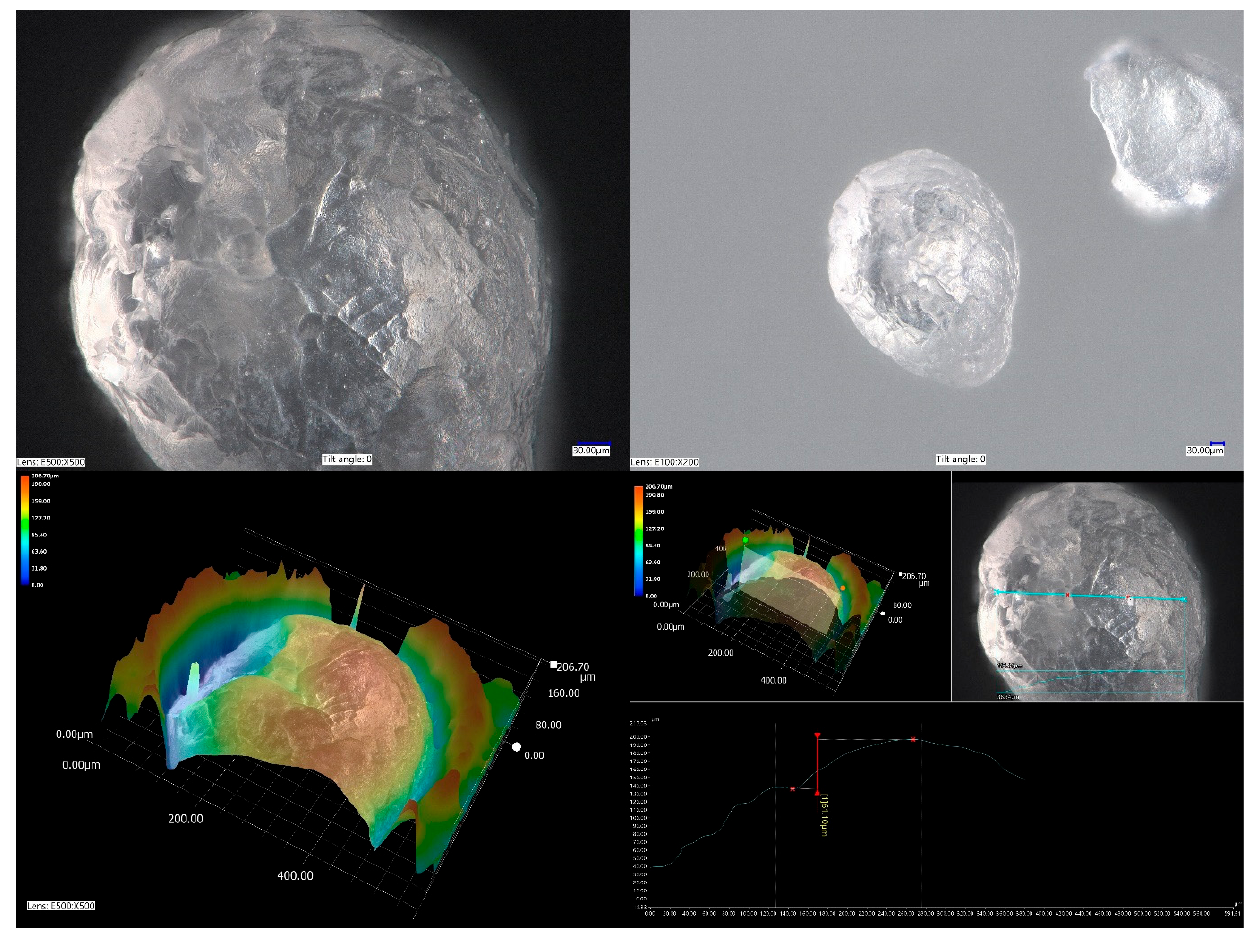
Figure 2. Microscopic photograph of non-saturated SAP S particle in dry conditions.